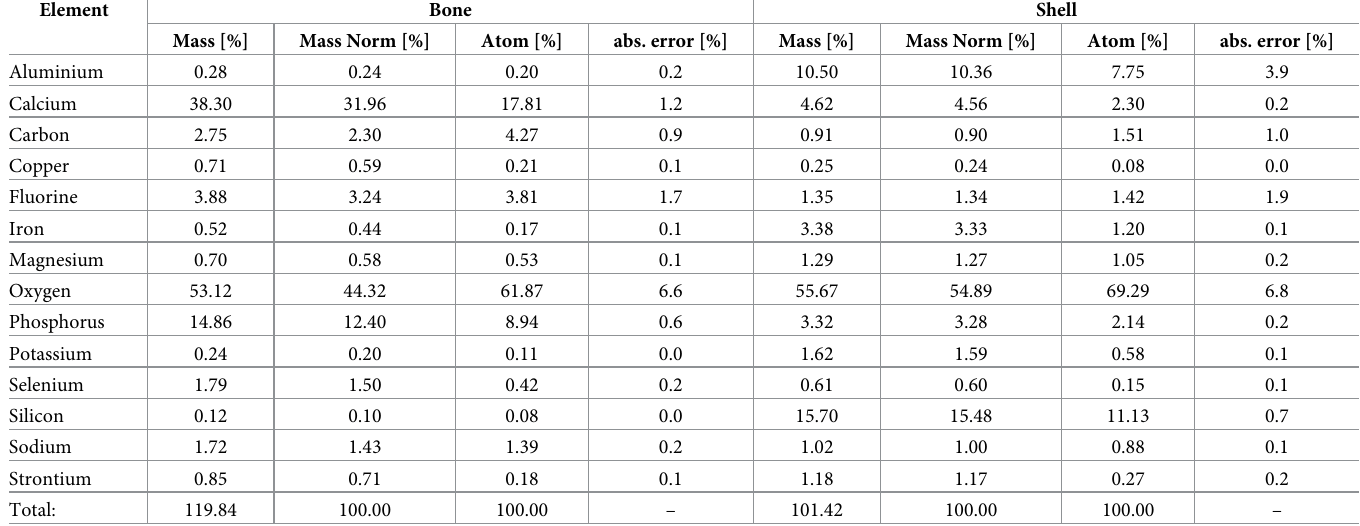
Table 1. EDS analysis results of the bone and